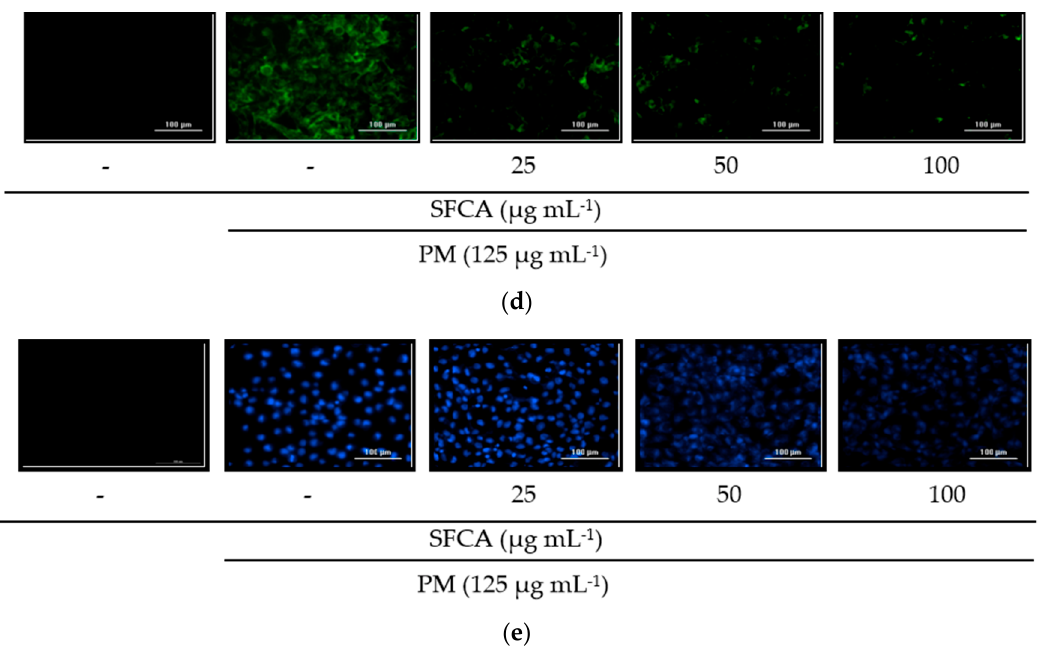
Figure 2. Protective effect of SFCA against inflammation induced by PM in HaCaT keratinocytes. ( a ) Analyses of HaCaT cell viability and intracellular ROS levels; ( b ) Western blot analyses of COX-2 expressions; and ( c ) ELISA of prostaglandin E 2 (PGE 2 ) and pro-inflammatory cytokines (IL-1 β , IL-6, and TNF- α ). Pre-seeded cells (1 × 10 5 cells mL − 1 ) were treated with or without different SFCA concentrations during 24 h and stimulated with PM after 30 min. Cells were harvested after 24 h to measure inflammatory mediators (COX-2 and PGE 2 ) and pro-inflammatory cytokines (IL-1 β , IL-6, and TNF- α ). Apoptotic body formation was observed under a fluorescence microscope after ( d ) DCFH-DA treatment and ( e ) Hoechst 33,342 staining. Graphical representations are means ± SE based on three replications. * p < 0.05 and ** p < 0.01 indicate that values were significantly different from those for the PM-treated group.